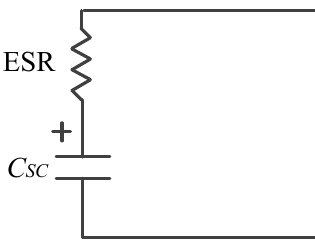
Figure 11. Classical model of the supercapacitor. ESR, equivalent series